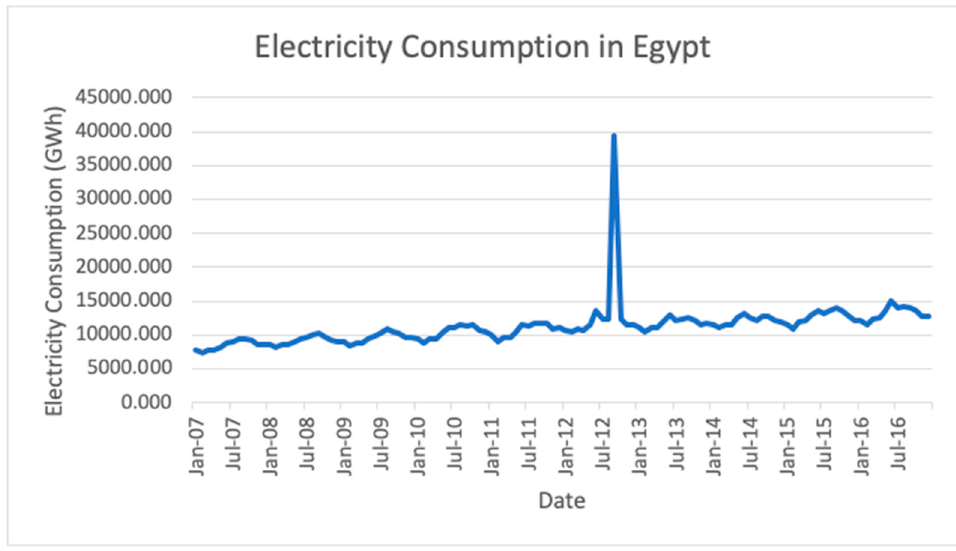
Figure 7. Electricity consumption in Malaysia from 2007 to 2016.